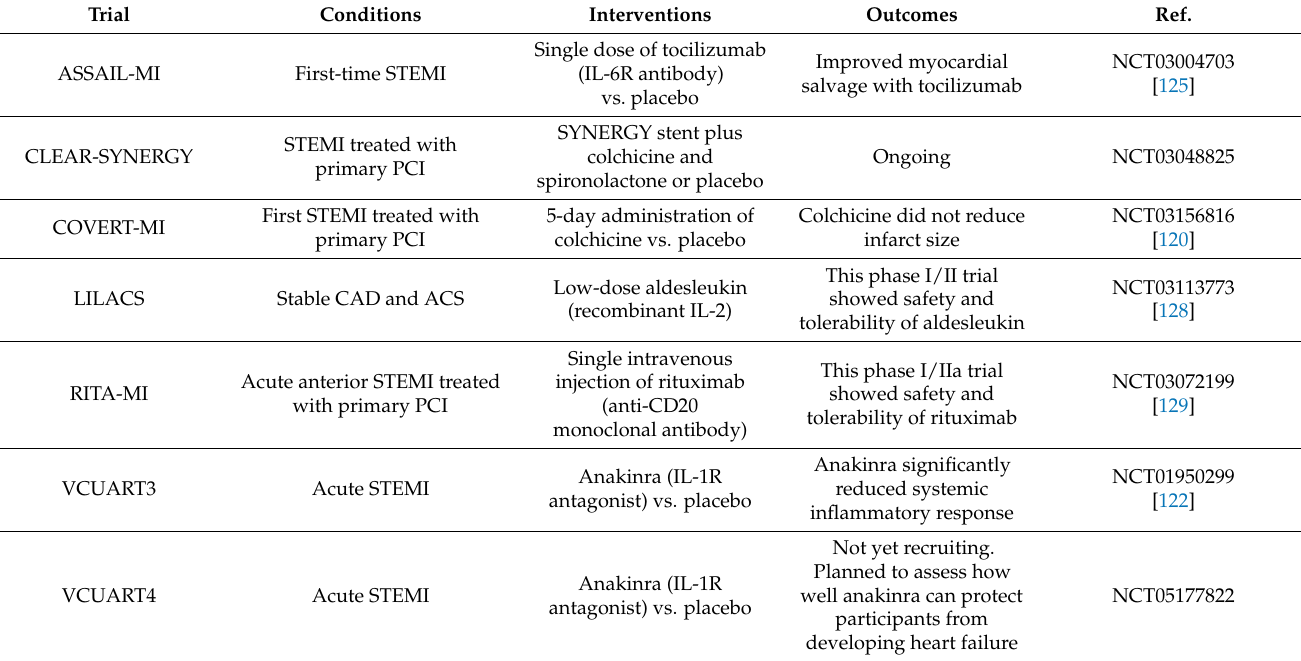
Table 1. Selected clinical studies targeting immune inflammatory pathways in myocardial